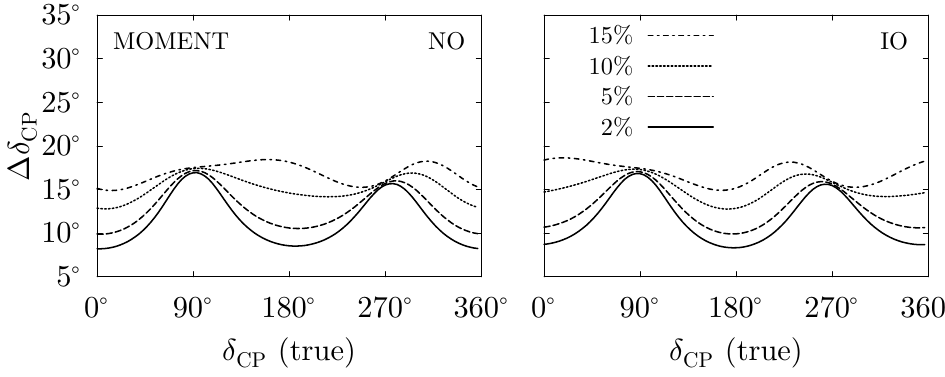
Figure 4. The e(cid:11)ect of the systematics on the precision measurement of (cid:14) CP . The 1 (cid:27) con(cid:12)dence level uncertainties for (cid:14) CP are shown as a function of values (cid:14) CP = 0 (cid:14) . . . 360 (cid:14) . The uncertainties are shown for four di(cid:11)erent scenarios where the systematic error on the signal normalization is set to either (cid:27) (cid:16) = 2%, 5%, 10% or 15%. The results are shown for both normal (NO) and inverted sg ordering